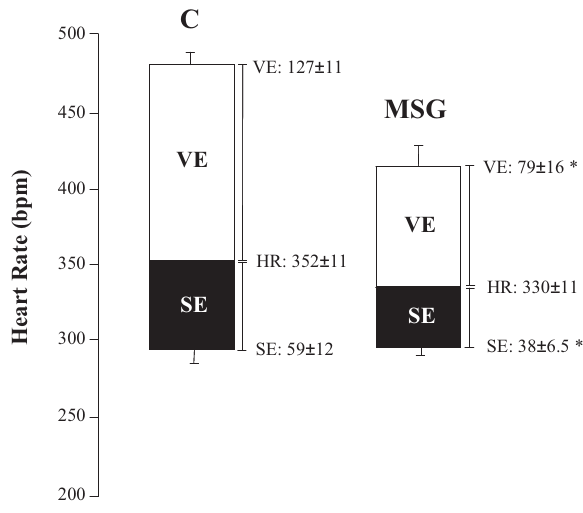
Figure 3 - Heart rate (HR) and sympathetic (SE) and vagal (VE) effects in the control (C) and monosodium glutamate-treated (MSG) rats (see "Methods" for calculation). Adjacent to the plots, the mean ¡ SEM. *Significant difference between the control and MSG groups ( p